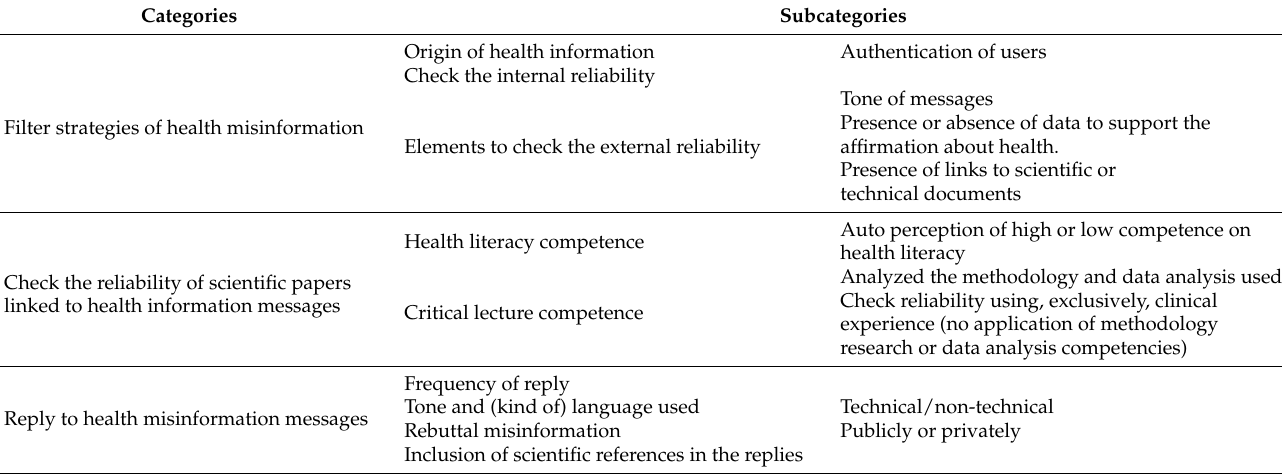
Table 1. Main categories and subcategories defined in the present